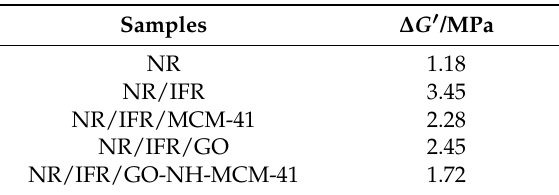
Figure 10. Dependence of G (cid:48) on strain of NR and FRNR composites. Table 5. ∆ G (cid:48)